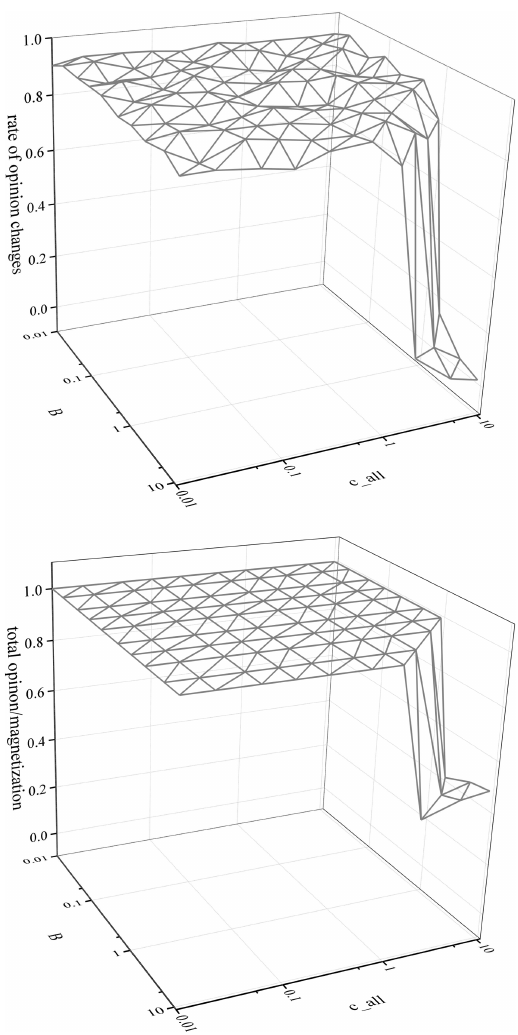
Fig. 5. The rate of opinion change (upper plot) and the ¯nal state of opinion for variable B and c all